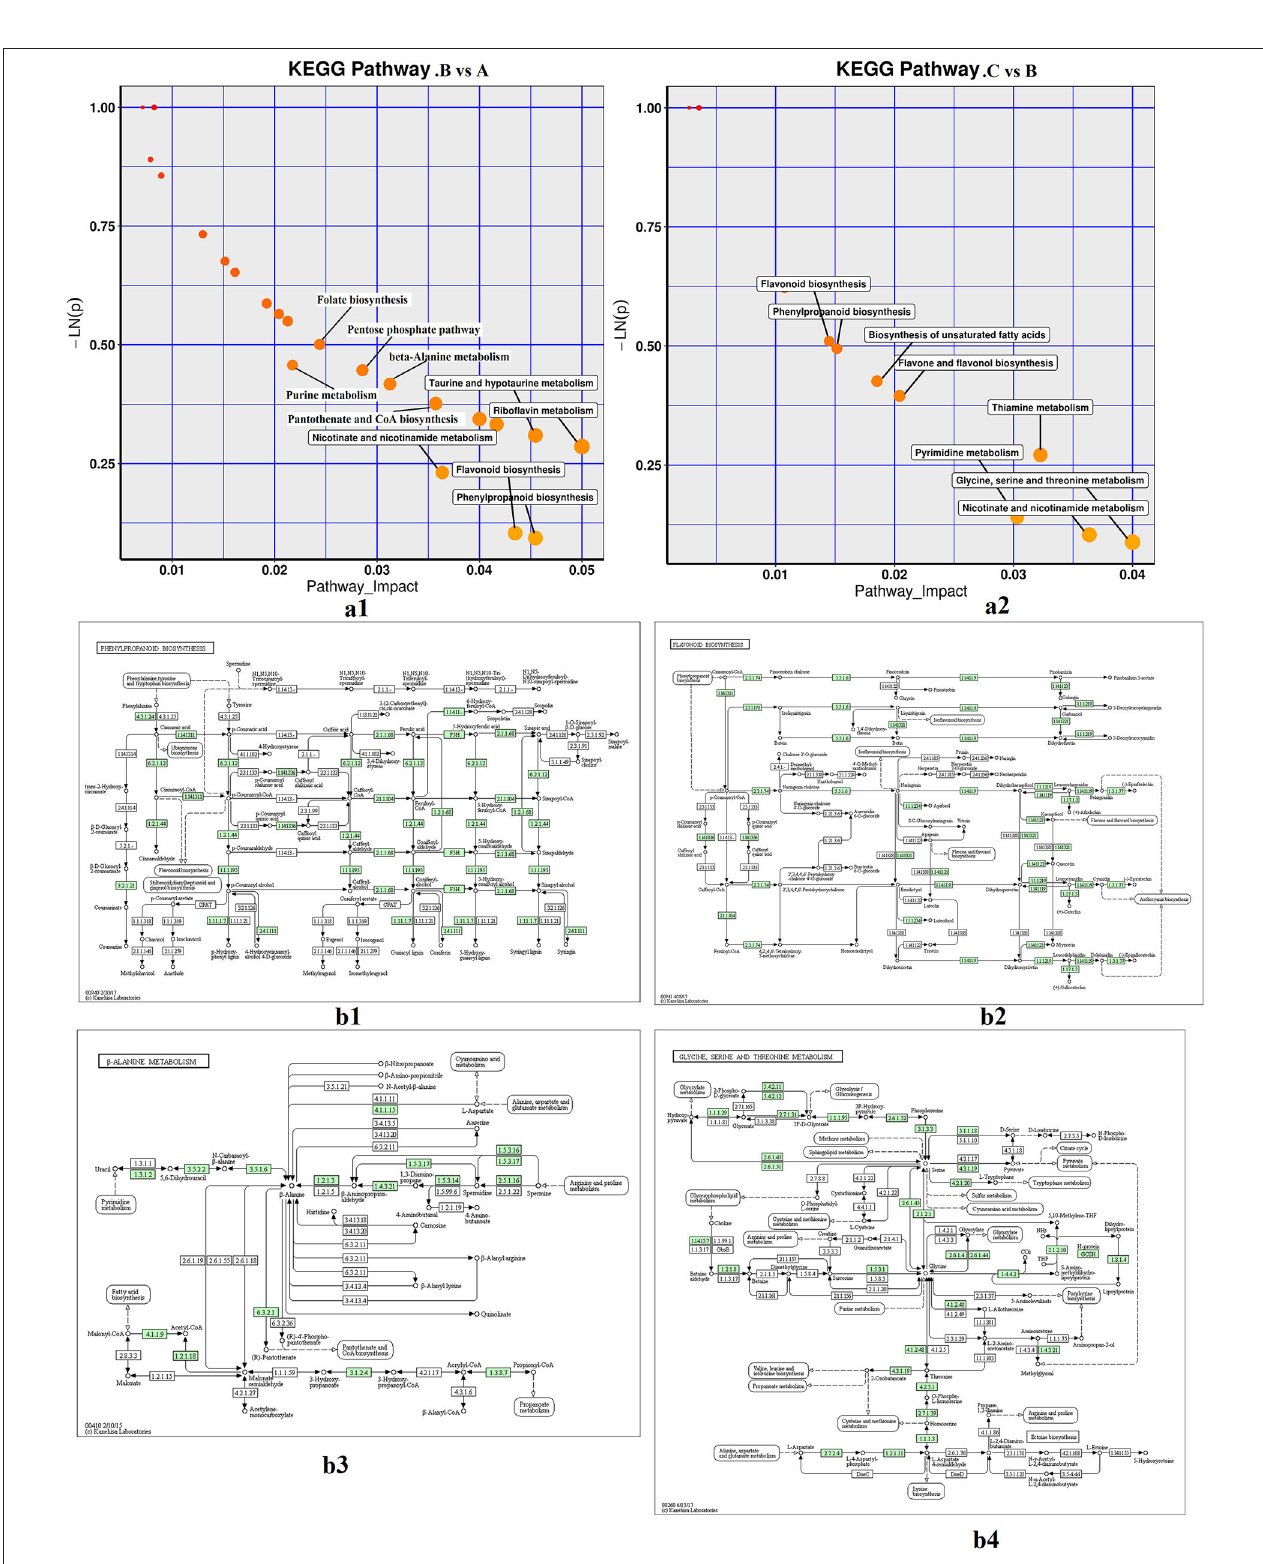
FIGURE 5 | Metabolic enrichment pathway analysis in two comparative groups (a1,a2) and important KEGG pathway maps (b1,b4) . (a1,a2) represent the enrichment analysis of different metabolites in the steaming and drying processes, respectively; (b1,b4) respectively represent phenylpropanoid biosynthesis pathway, flavonoid biosynthesis pathway, alanine metabolism pathway, glycine, serine and threonine metabolism pathway. A, fresh; B, steamed without drying; C, dried after steaming. KEGG, Kyoto Encyclopedia of Genes and Genomes.